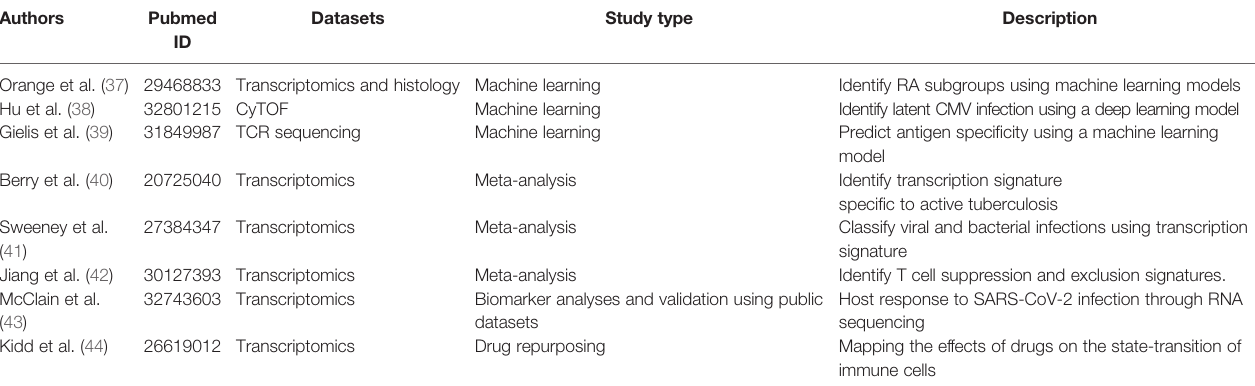
TABLE 1 | List of publications leveraging open-access immunological